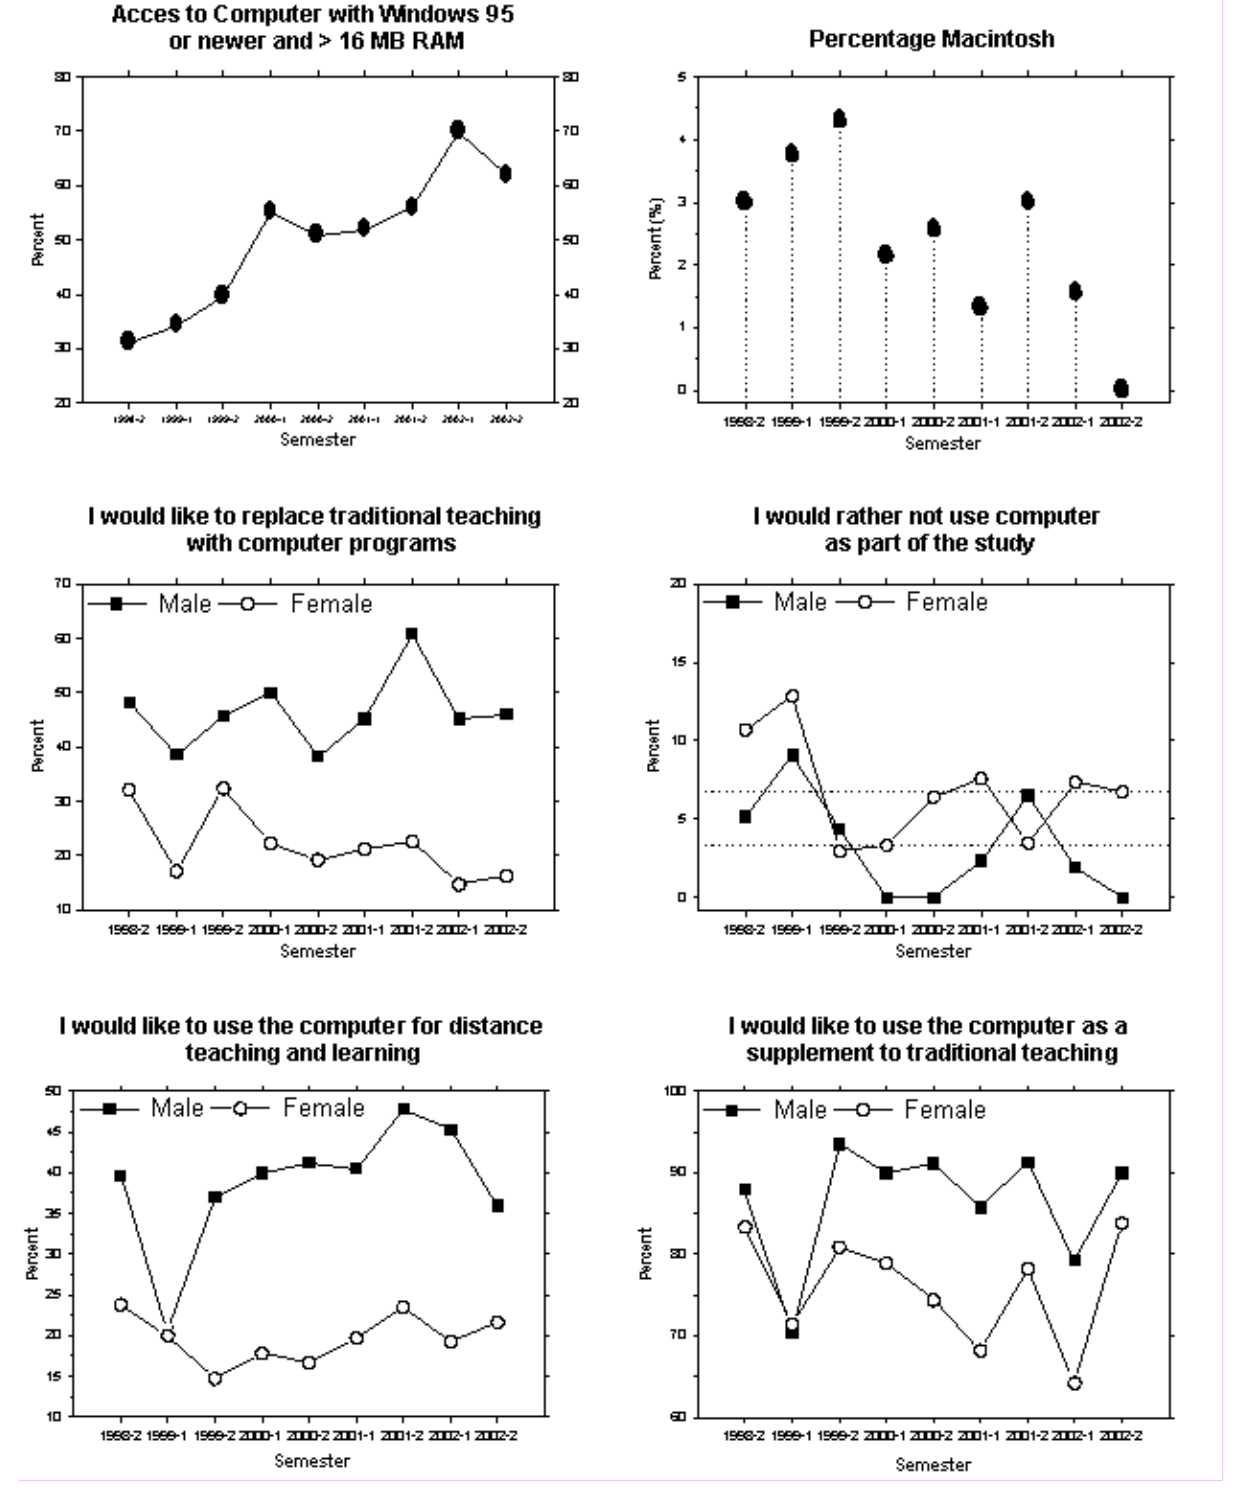
Figure 2. Type of computer (a, b) and attitudes towards use of computer (c to f). Spring semesters are indicated with 1 ; fall semesters with 2 . As might be expected, the number of powerful computers among students was increasing; The percentage of Macintosh computers was decreasing. 6.8% of females answered that they would rather not use a computer as part of the study. The corresponding percentage for males was